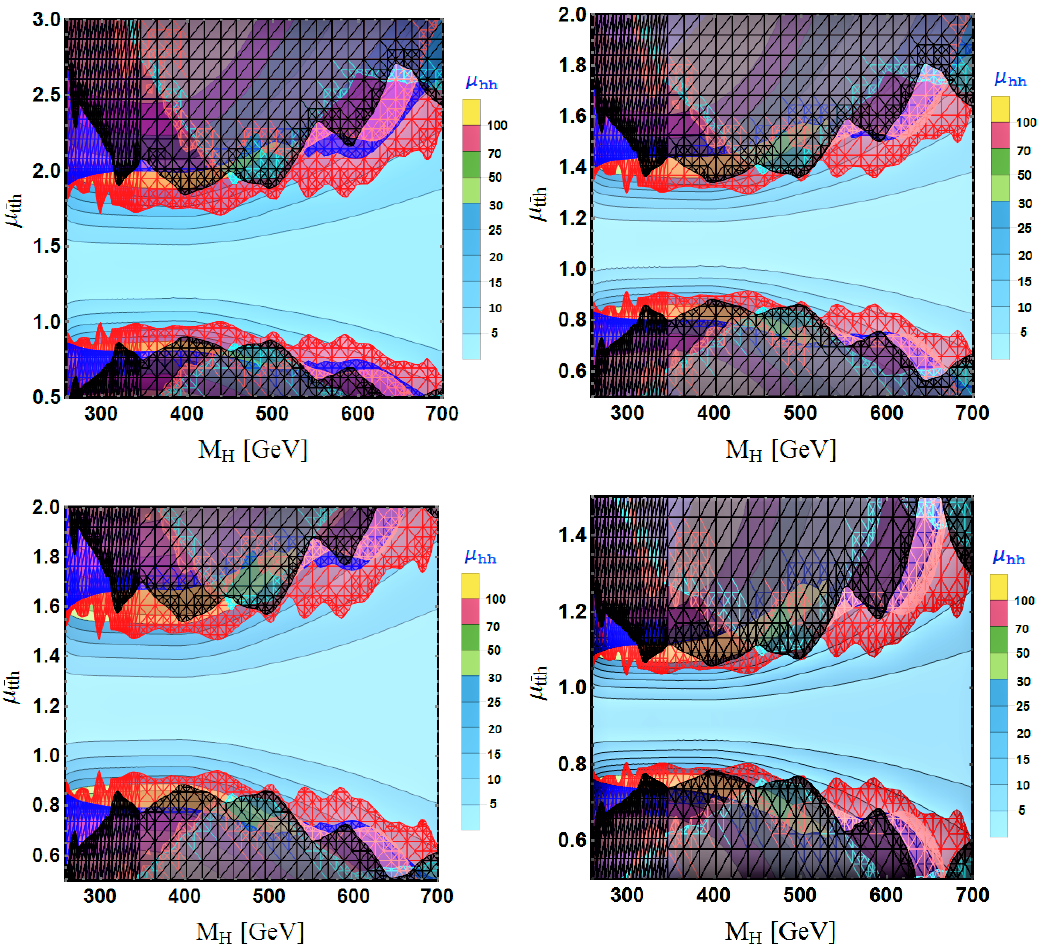
Figure 8 . Contour plot of (cid:22) hh in (cid:22) -M H plane. The scaling of (cid:22) hh is shown on right side of t (cid:22) th the each (cid:12)gure. Black, pink and cyan colored meshed zones are excluded parameter space from current di-Higgs limit looking at di(cid:11)erent (cid:12)nal states b (cid:22) b(cid:13)(cid:13); b (cid:22) bb (cid:22) b and b (cid:22) b(cid:28) + (cid:28) (cid:0) respectively; red and blue meshed zone is the excluded parameter space from the resonant ZZ and W + W (cid:0) production constraints. We have used a typical set of parameters (sin( (cid:11) (cid:0) (cid:12) ) = 0 : 5 ; ~ Y b = (cid:0) 0 : 09 ; ~ Y (cid:28) = 10 (cid:0) 3 ) for top left; (sin( (cid:11) (cid:0) (cid:12) ) = 0 : 3 ; ~ Y b = (cid:0) 0 : 09 ; ~ Y (cid:28) = 10 (cid:0) 3 ) for top right; (sin( (cid:11) (cid:0) (cid:12) ) = 0 : 4 ; ~ Y b = 0 : 02 ; ~ Y (cid:28) = 10 (cid:0) 3 ) for bottom left and (sin( (cid:11) (cid:0) (cid:12) ) = (cid:0) 0 : 2 ; ~ Y b = 0 : 04 ; ~ Y (cid:28) = 10 (cid:0) 3 ) for bottom